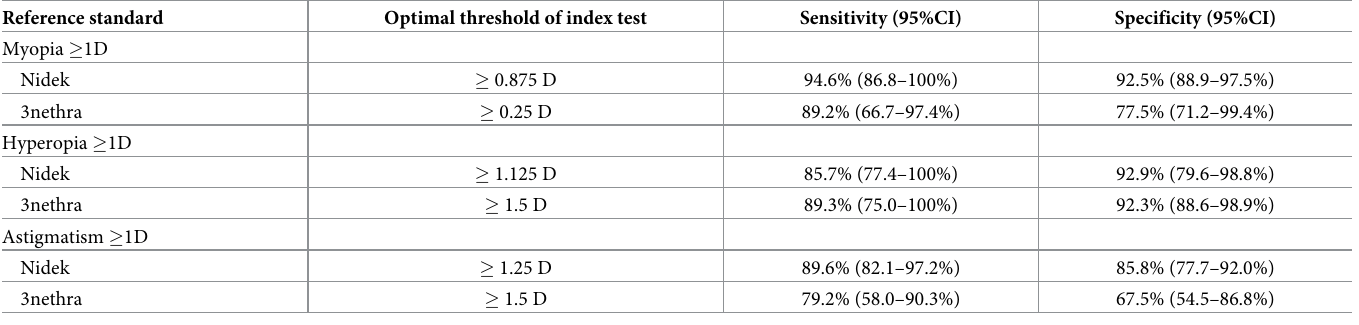
Table 3. Sensitivity and specificity of two autorefractors relative to subjective refraction. The optimal test threshold for each index test relative to each reference stan- dard was assessed from the Youden index of the respective receiver operating characteristics (ROC) curve. Diagnostic accuracy was assessed in 197 eyes from 104 people aged 50 years or